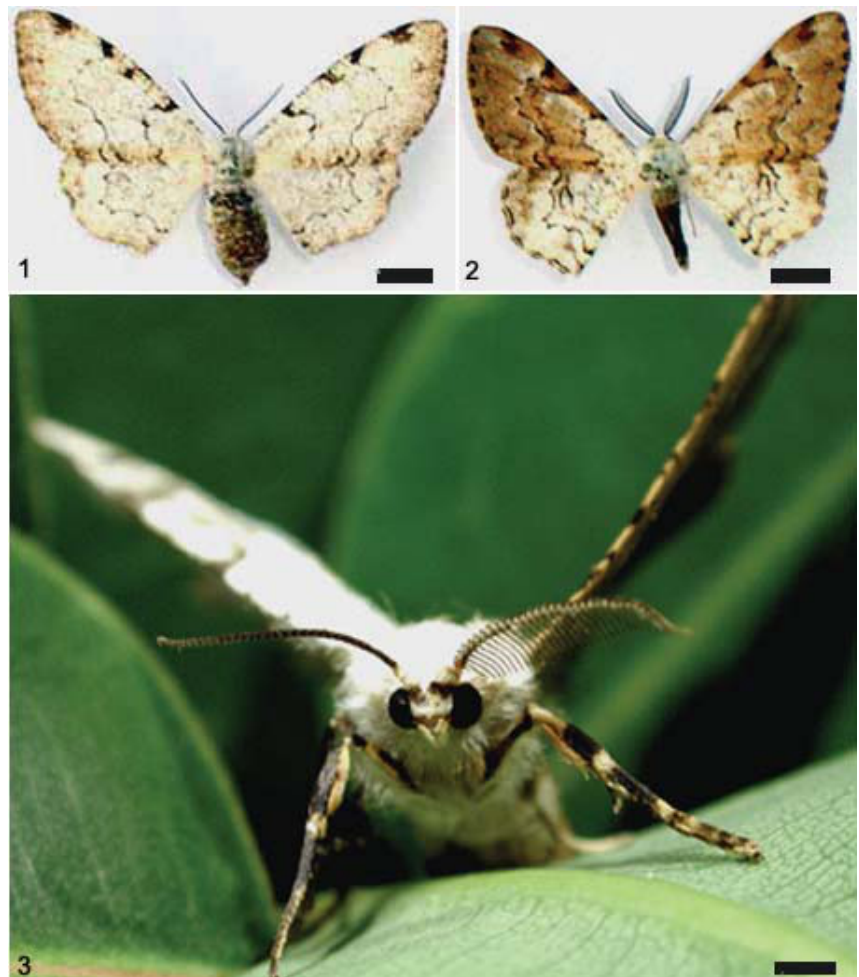
Fig. 1 – The normal Thyrinteina arnobia female. Note wing coloration and filiform antennae. Scale bar = 0.5 cm. Fig. 2 – The normal Thyrinteina arnobia male. Note wing coloration and pectinated antennae. Scale bar = 0.5 cm. Fig. 3 – The Thyrinteina arnobia gynandromorph. Note the male characters (brown wings, larger eyes and pectinated antenna) on the left side and female characters (clear wings, filiform antenna and smaller eyes) on the right side. Scale bar = 0.1